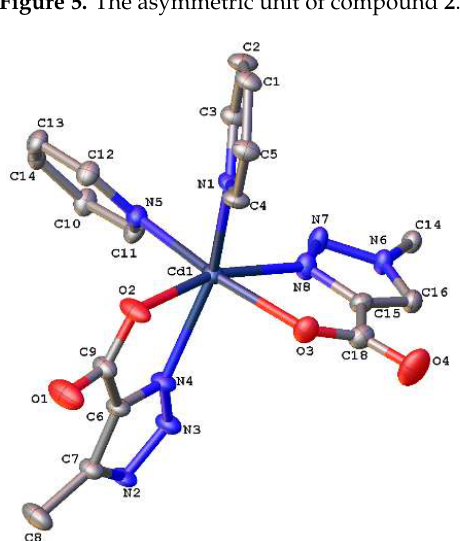
Figure 6. Coordination environment of [Cd(L2)]n cores.